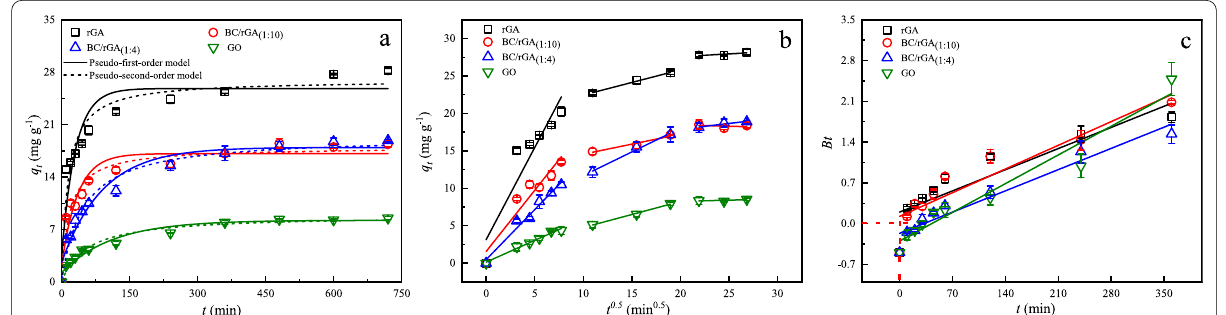
Fig. 4 Adsorption kinetic fitting of Cr(VI) on GO and aerogels: pseudo-first order-model and pseudo-second-order model ( a ), intra-particle diffusion model ( b ) and Boyd model ( c